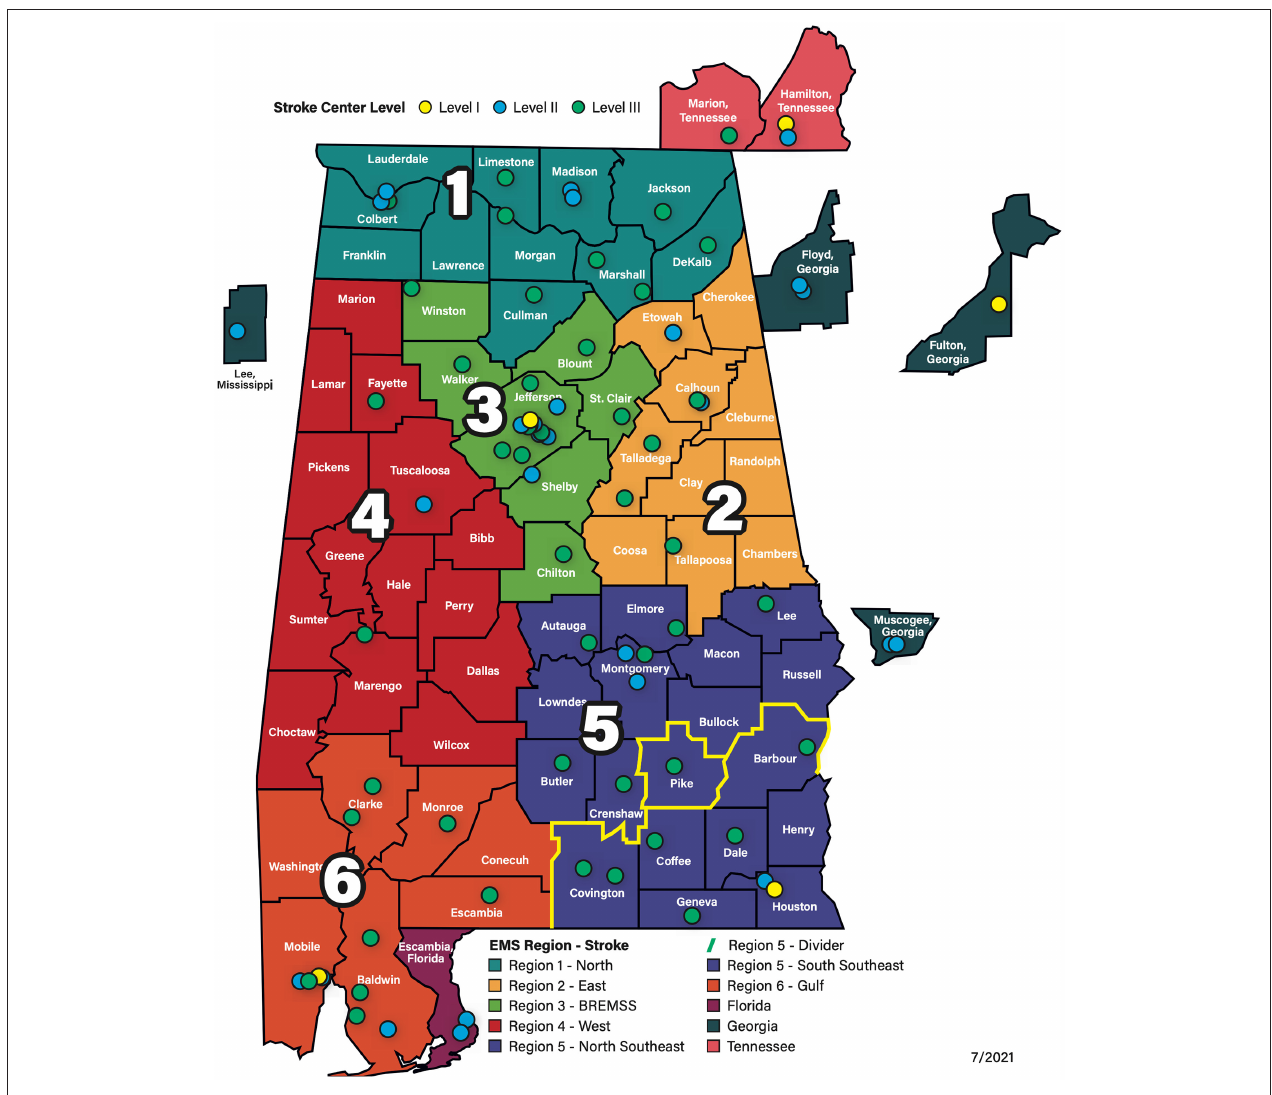
FIGURE 1 | Alabama EMS Regions and Stroke Centers. The Alabama stroke system has 80 stroke centers. Level III centers (green dots) are acute stroke-ready hospitals, level II centers (blue dots) are primary stroke centers, and Level I centers (yellow dots) are comprehensive stroke centers. See text for details regarding primary stroke centers that are currently thrombectomy-capable. Map Source: